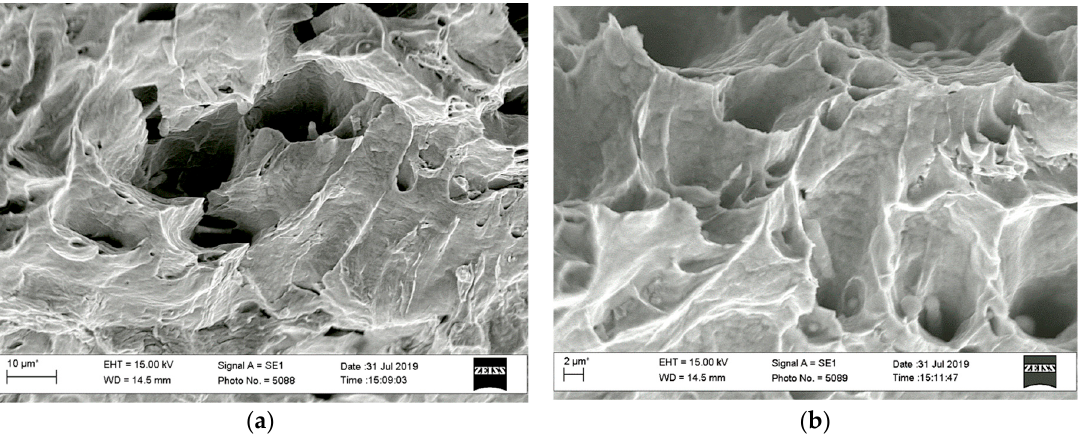
Figure 17. Fractograms of the specimen loaded according to the K I – K III scheme (with the K III type loading up to 45 degrees), at the stage of spontaneous crack growth: ( a ) 10 μ m; ( b ) 2 μ m.